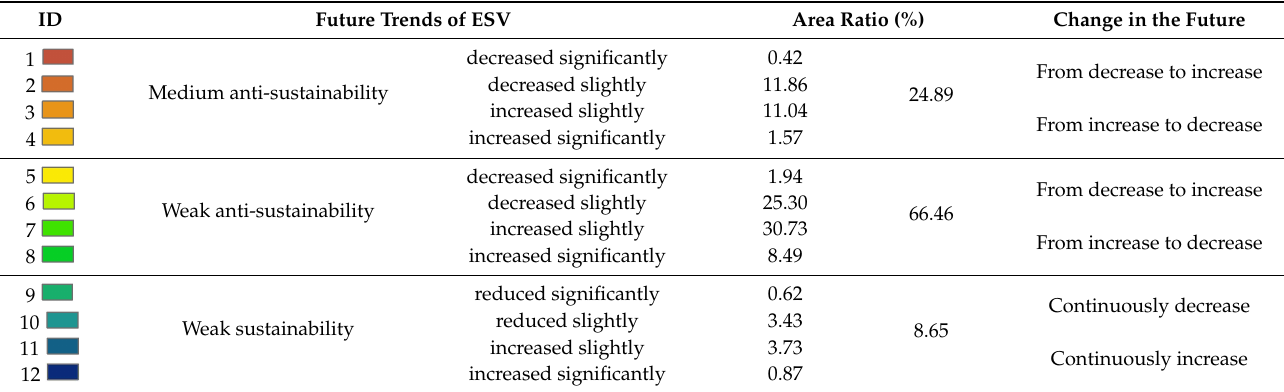
Table 7. Area ratio with different future trends of grassland ESV in Inner Mongolia.